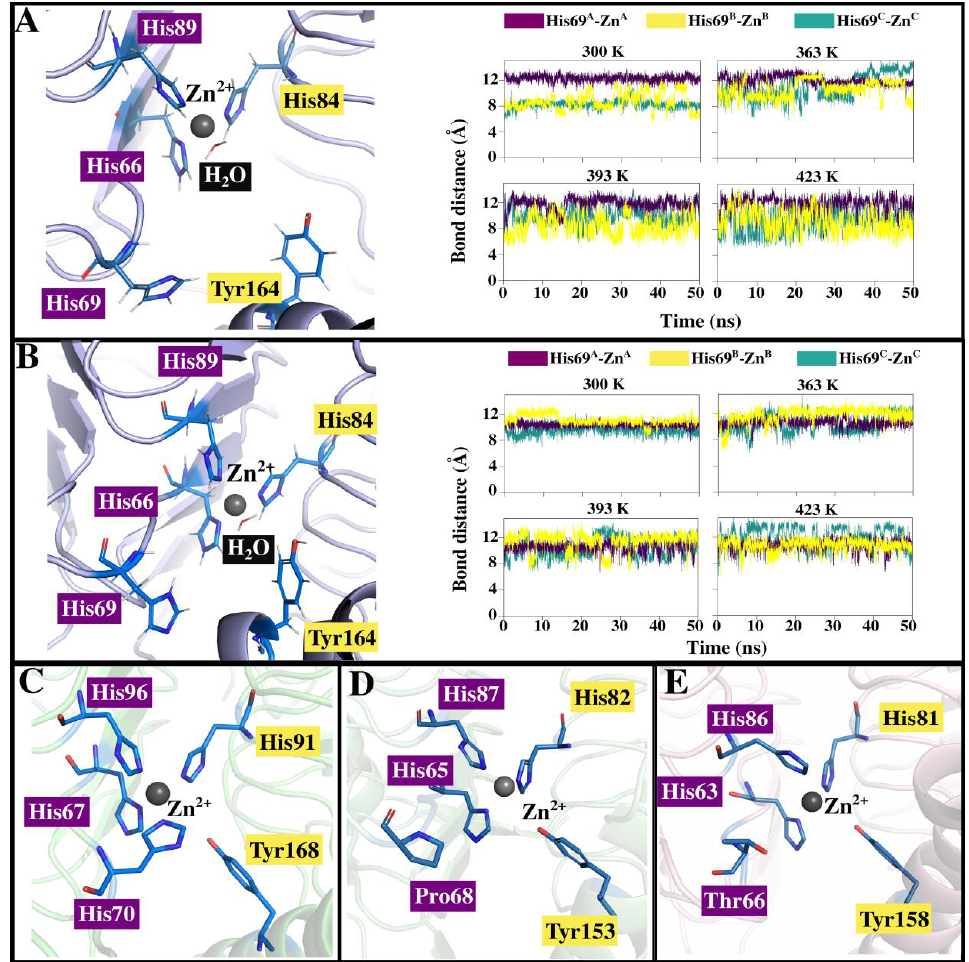
Figure 5. ( A , B ) show position of His69 in the active sites of γ - PhCA and γ -PmCA respectively as well as plots illustrating its bond distance from Zn 2+ during simulations at 300 K, 363 K, 393 K and 423 K. ( C ) shows His70 taking up the fourth coordination position in EcoCA- γ. ( D , E ) show the active site of γ - TtCA and γ - TtkCA, with Pro68 and Thr66 respectively, in place of γ - PhCA’s His69. site of γ -TtCA and γ -TtkCA, with Pro68 and Thr66 respectively, in place of γ -PhCA’s